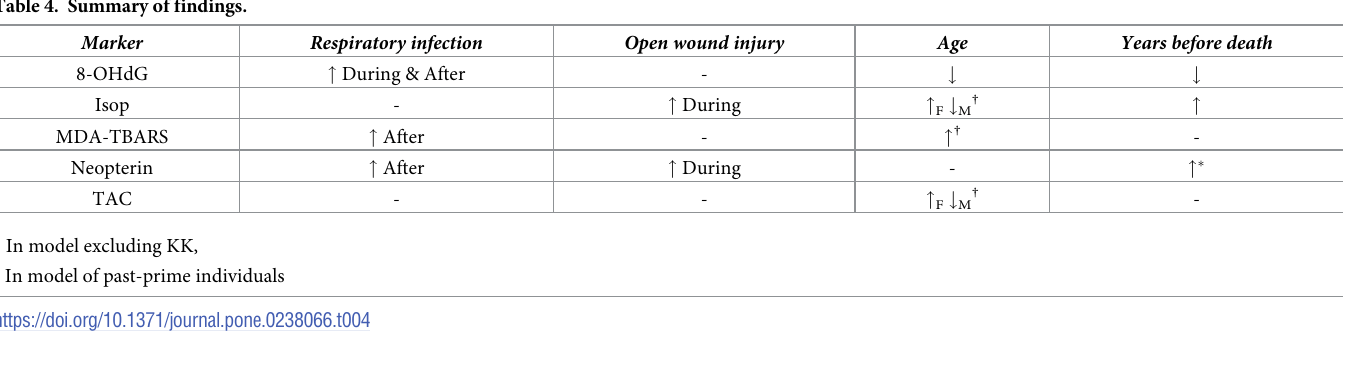
cross-sectional and mixed-longitudinal studies [69,70,86,98–102], but not always [23,55,103– 106]. For example, urinary 8-OHdG increased with age in all patients with muscular dystrophy [86] and between certain age categories in a large cross-sectional sample of men and women [100], but did not increase with age in pollution-exposed silica miners [106].